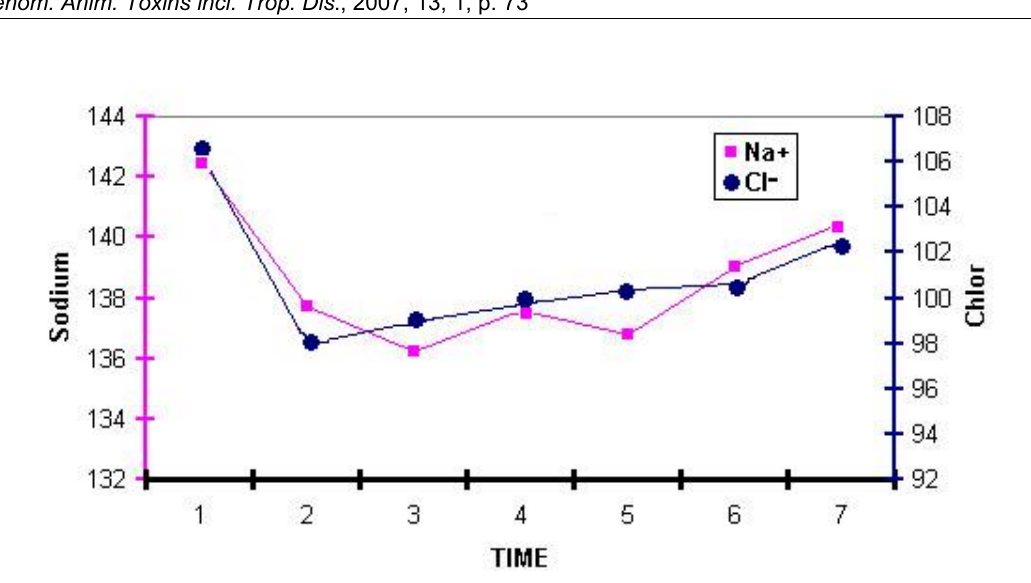
Figure 2: Comparison between Na + (Sodium) and Cl - (Chlor) ions levels after administration of Androctonus crassicauda venom to rats. A statistically positive correlation ( p <0.001) was observed.